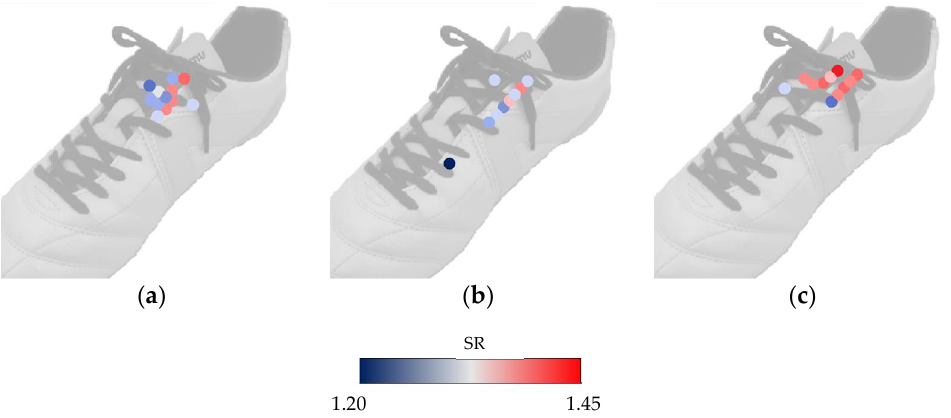
Figure 4. The Blue-Red color scaled Foot-to-ball speed Ratio on each impact point of each trial. The farther point from heel to toe showed the lower foot-to-ball speed ratio value especially on curve trial. ( a ) Color scaled SR of straight trial; ( b ) Color scaled SR of curve trial; ( c ) Color scaled SR of knuckle trial.